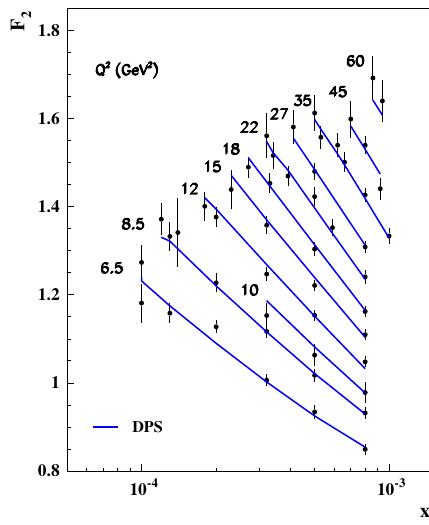
Fig. 10 Comparison of the AB fit results with data